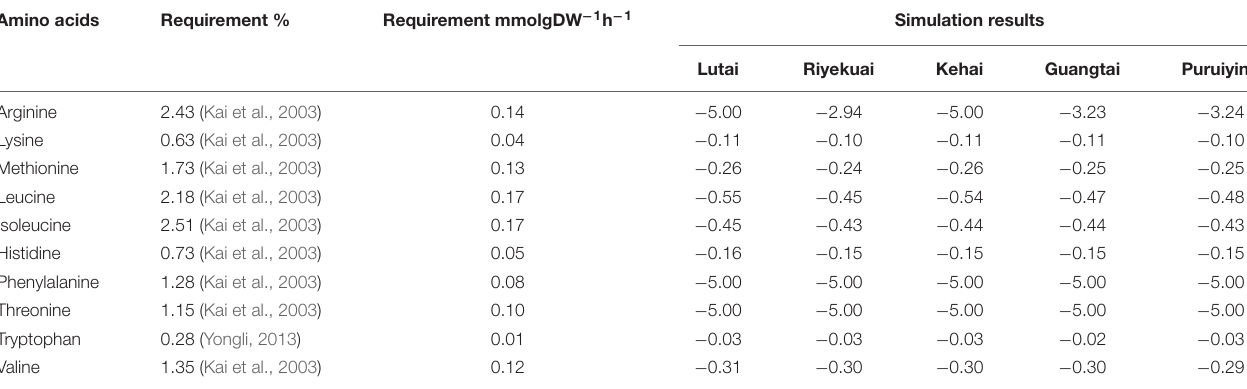
TABLE 5 | Requirements of essential amino acids by L. vannamei in literature and simulation results. Amino acids